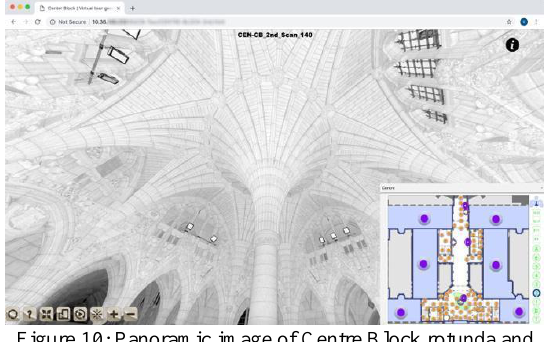
Figure 10: Panoramic image of Centre Block rotunda and key plan with hotspots as viewed in HTML